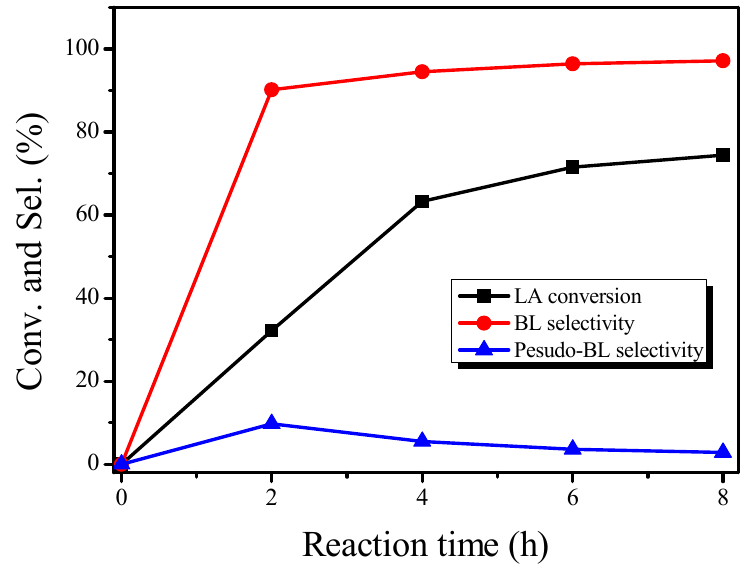
Figure 5. Influence of reaction time on the esterification of LA. Reaction conditions: LA: n-butanol = 1:10, catalyst loading: 10 wt.% (based on the LA mass), and reaction temperature: 120 °C.